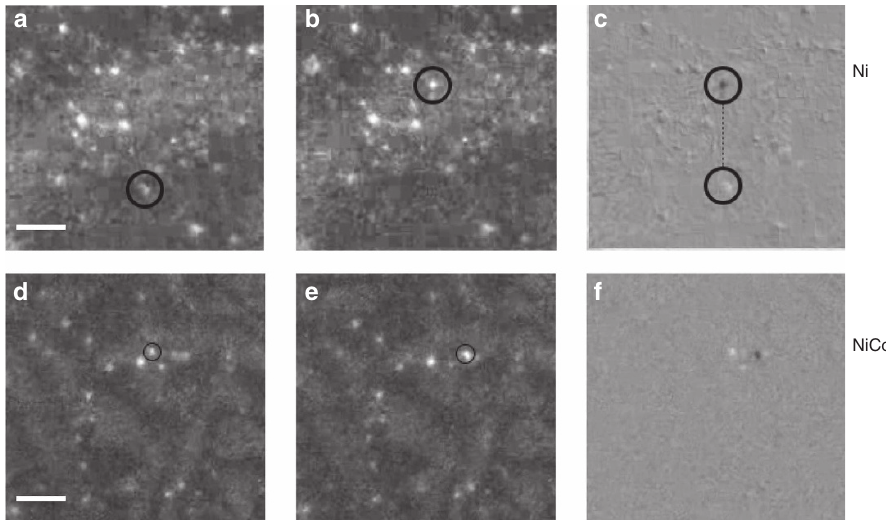
Figure 5 | 1D glide of interstitial clusters in nickel and NiCo. Observations were conducted by in situ TEM. ( a ) The initial position of the dislocation loop in nickel, ( b ) the final position of the loop in nickel, ( c ) superimposing image of the initial and final position of loop in nickel, ( d ) the initial position of the loop in NiCo, ( e ) the final position of the loop in NiCo and ( f ) superimposing image of the initial and final position of loop in NiCo; scale bar,